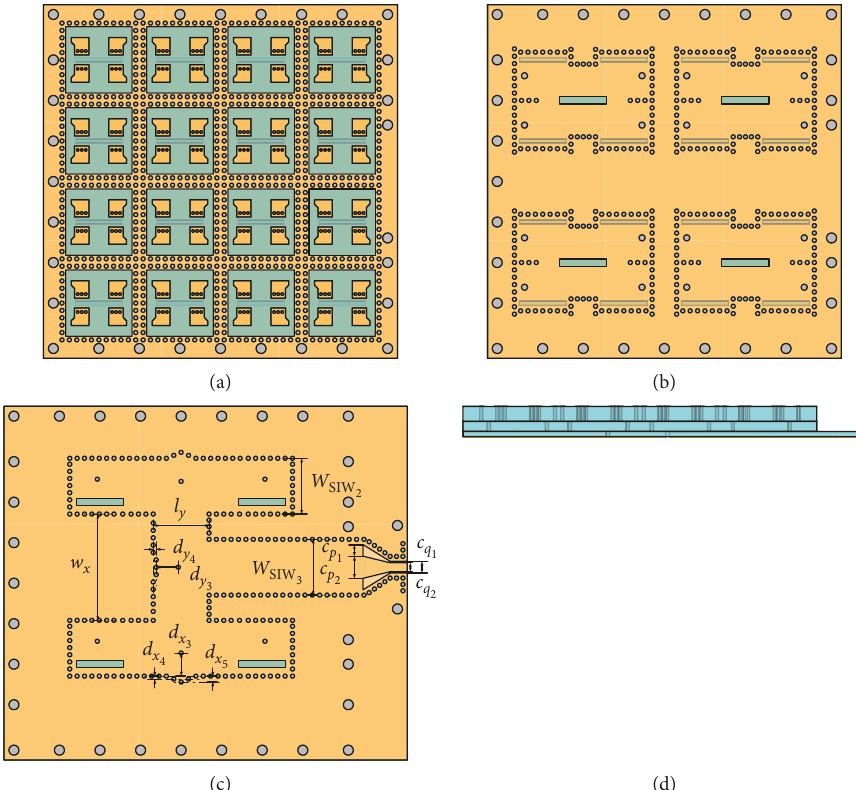
Figure 14: Configuration of the proposed 4 × 4 ME dipole antenna array with two-layer full-corporate SIW feeding network. (a) Top view of the radiation structure in substrate 3. (b) Top view of the corporate SIW feeding network in substrate 2. (c) Top view of the H-shaped feeding network in substrate 1. (d) Left